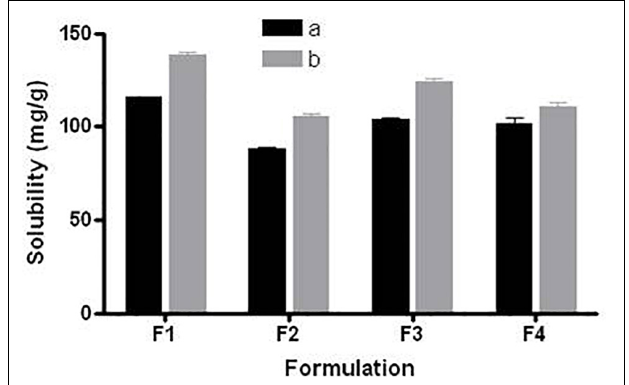
FIGURE 2 | Equilibrium solubility of fenofibrate in group “a” and group “b” of LFCS formulations containing alternation lipid excipients. The formulation represent F1a- C70, F1b- K70, F2a- C70: CMCM (7:3)/TO106V (1/1), F2b- K70:I742(7:3)/TO106V(1/1), F3a- C70: CMCM (7:3)/HCO-30 (1/1), F3b-